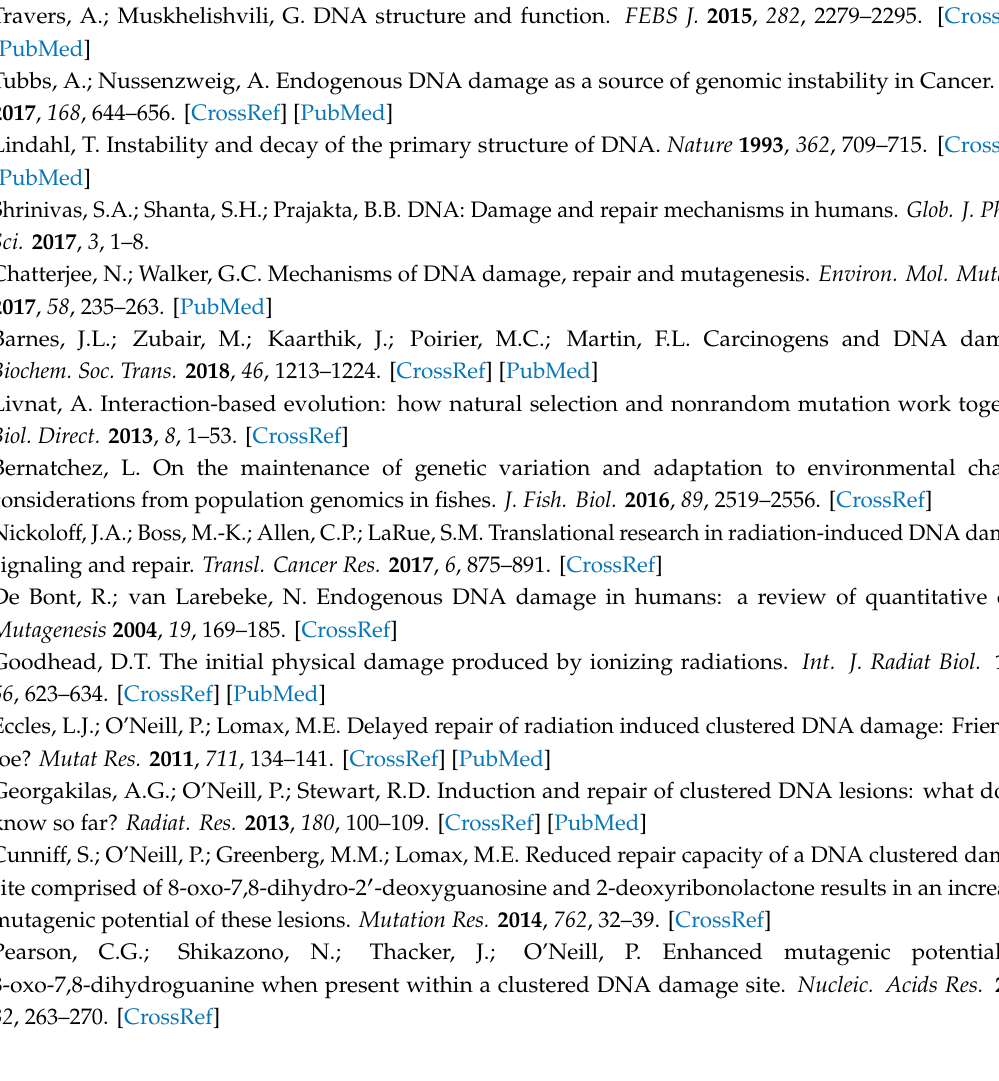
Figure S1: CD spectra of investigated ds -oligonucleotidestitle, Figure S2: The graphical representation of selected amino acids extracted from 1emh.pdb file, Figure S3: Spectra of Oligonucleotide Mass Spectrometry Analysis, Table S1: Sequence of oligonucleotides, Tables S2: The raw data presented by graphs on Figure.3. Average and corresponding standard deviations values, PDB files: Cont_pdU.pdb, RcdA( + 1)SM.pdb, RcdA(-1)SM.pdb, ScdA( + 1)SM.pdb, ScdA(-1)SM.pdb and Selected aminoacids indication in 1emh structure.msv. Author Contributions: B.T.K.